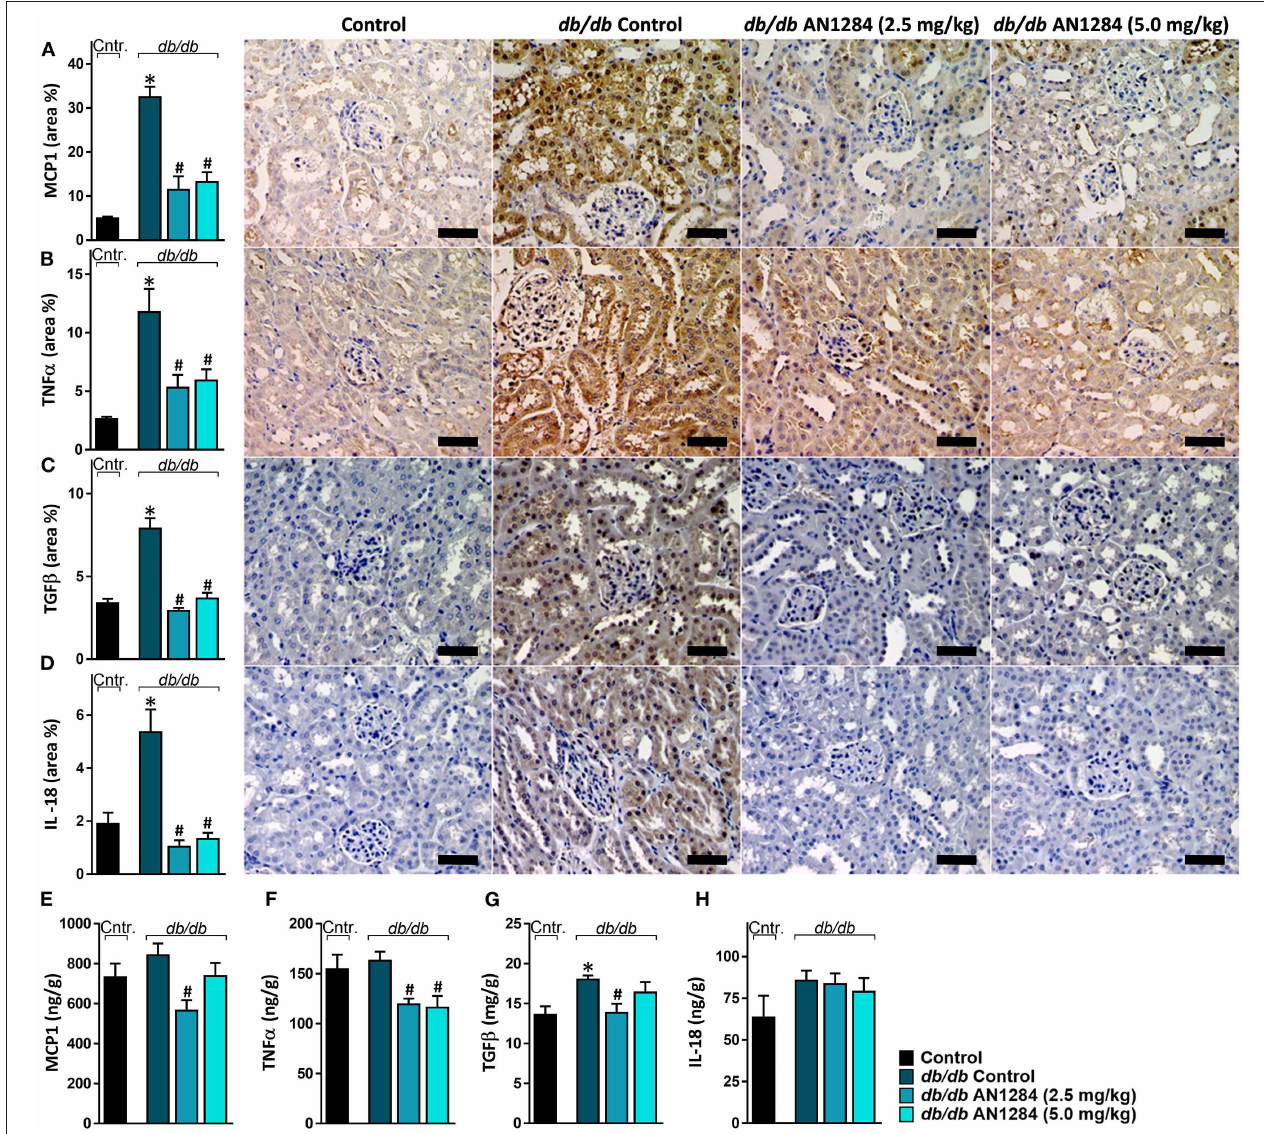
FIGURE 3 | AN1284 prevents the renal inflammatory response in type 2 diabetic mice. The elevated renal protein expression levels of the inflammatory markers MCP-1 (A,E) , TNF α (B,F) , TGF β (C,G) , and IL-18 (D,H) in db/db mice were normalized by AN1284 treatment. Scale bar, 50 µ m. Data represent the mean ± SEM from 8 to 10 mice per group. * P < 0.05 relative to control non-diabetic mice, # P < 0.05 relative to db/db -Veh-treated control